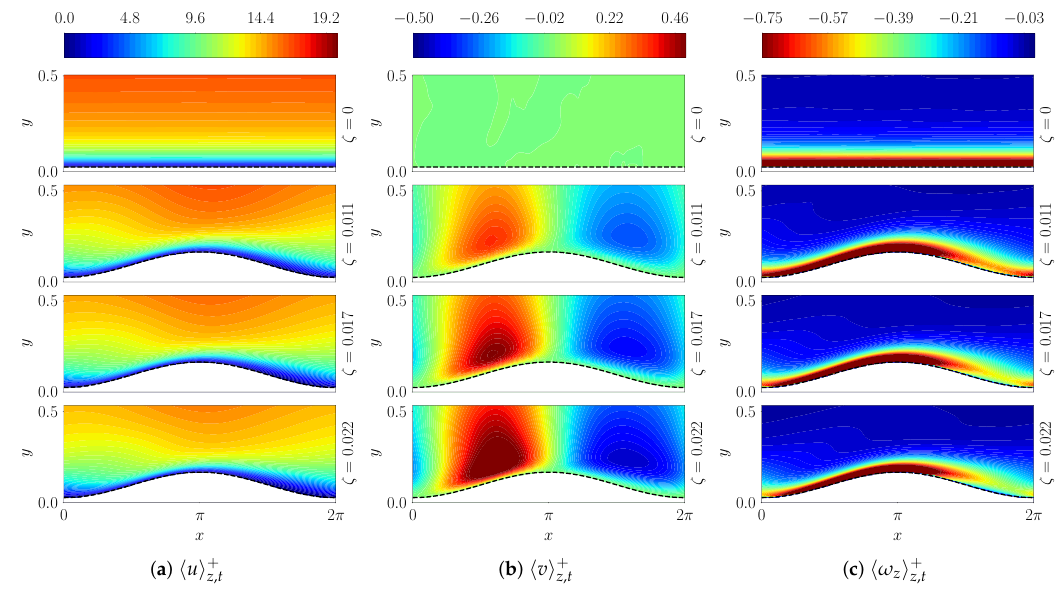
Figure 7. Spanwise and temporally averaged ( a ) streamwise velocity, ( b ) vertical velocity, and ( c ) spanwise vorticity over wavy surfaces in turbulent channel